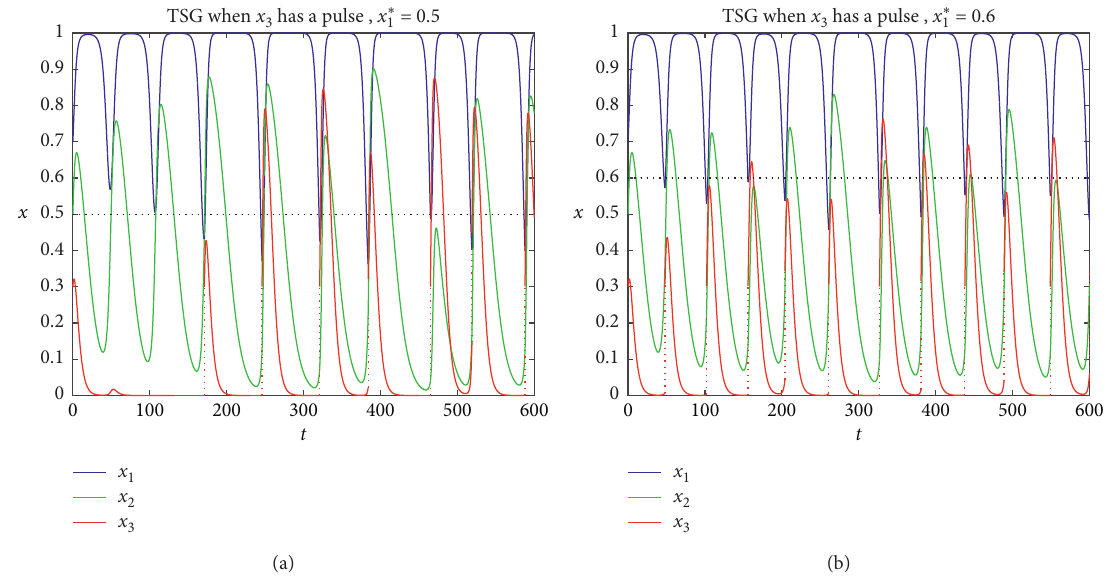
Figure 3: TSGs of DIDEs (2) when x